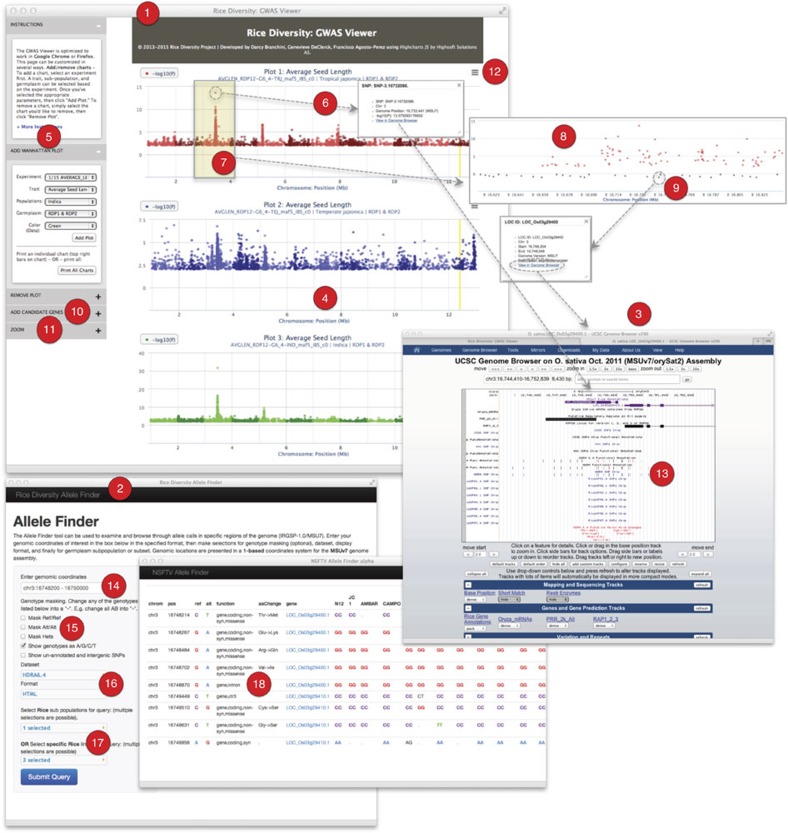
Data visualization tools.The GWAS Viewer (1) and the Allele Finder (2) were developed by the Rice Diversity Project to facilitate interpretation of GWAS results and the HDRA genotype data set. A local instance of the UCSC Genome Browser (3) was also created. All are available for public use at www.ricediversity.org. Users can select up to six plots to display in the main GWAS Viewer pane (4) by making selections in the control panel at the left (5). Points display SNP ID, position and P value when moused-over. Clicking on a data point (6) provides similar information in a pop-up window, along with a hyperlink to the Genome Browser. Users can highlight and zoom-in on a particular region by holding a click and dragging over (7,8) the region. When zoomed-in the IRGSP-1.0/MSU7 genome annotation features are displayed as grey triangles (9) and can be moused-over or clicked on for more information. Users can enter up to 100 MSU7 LOC IDs in the ‘Add Candidate Genes' box (10) for display on a selected plot as orange triangles. A synchronized-zoom feature is available (11). Print or download an image by clicking at the top right of the plot (12), or click on the ‘Print All Charts' button to print or download all plots displayed in the current session. Our local instance of the UCSC Genome Browser has several tracks of data (13) in addition to the IRGSP-1.0/MSU7 annotation; these include the RAP-DB genome annotation56, positions of SNPs on the Rice Diversity HDRA, the 44 K (ref. 17) and 1,536 (ref. 57) SNP chips and their functional annotations, and SNP sets from the Rice OPA breeder's mini-chips52. The Allele Finder tool allows the user to quickly find, examine and interpret specific regions of HDRA genotype data set. Enter a genome region of interest (14), select masking and display options (15), a data set and output format (16), select germplasm groups or subpopulations (17), and click the submit button. Along with the allele data the query results (18) display position information, reference and alternate allele, functional information, LOC_Os IDs, and predicted amino acid changes.